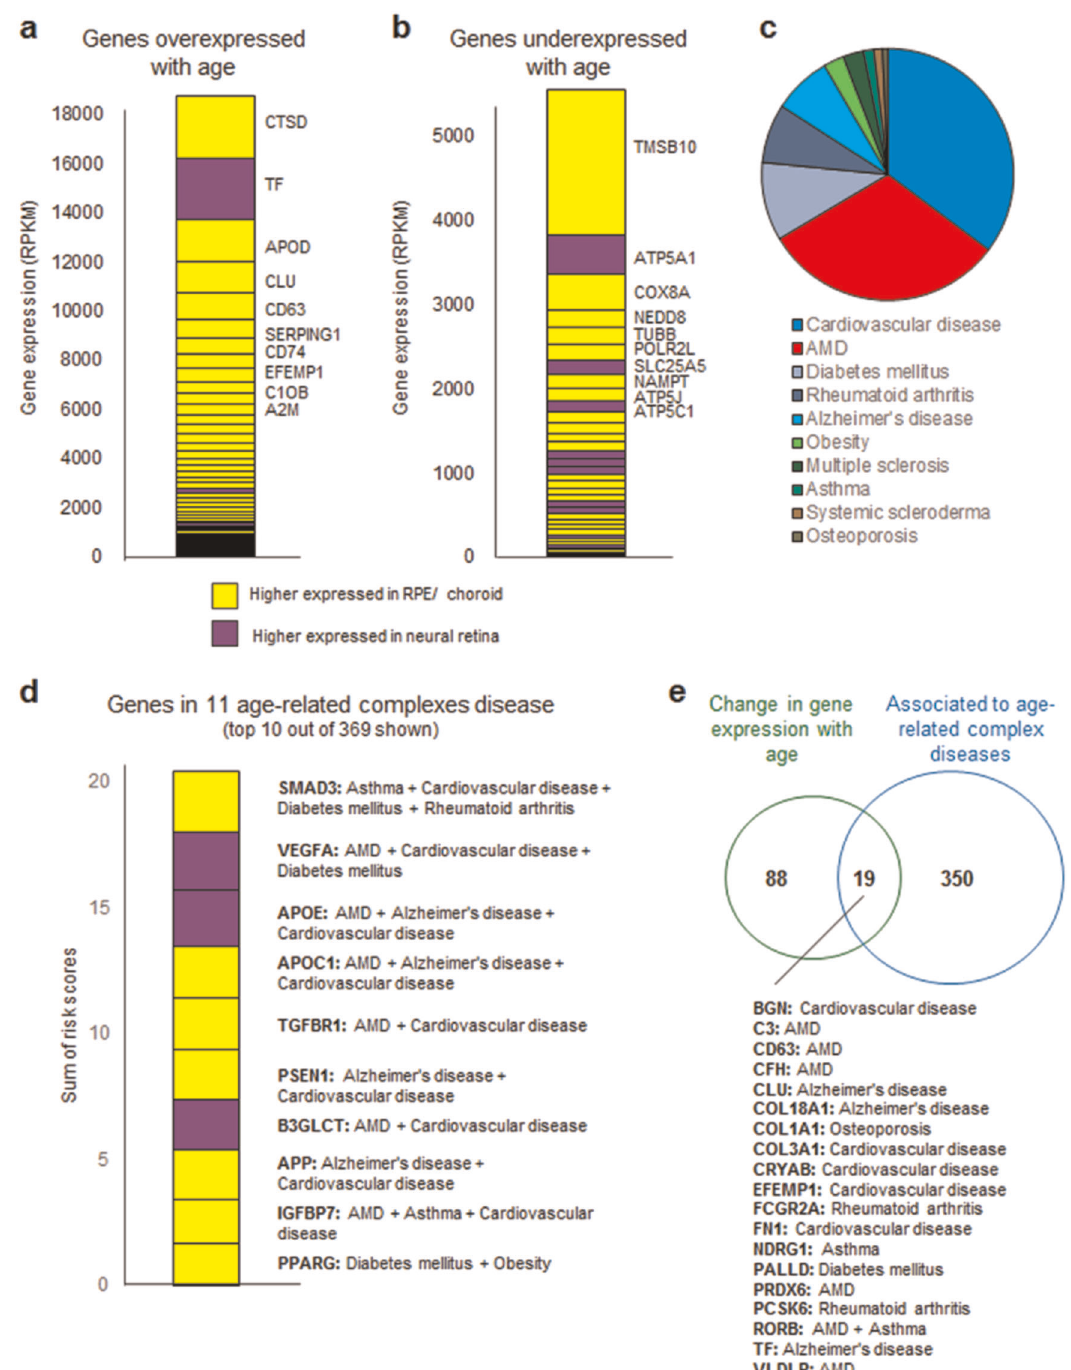
Fig. 5 Analyses of the 2060 SBGN-PPI union proteins. a Genes overexpressed with age and their respective expression levels in neural retina (purple) or RPE-choroid (yellow) are shown. a Genes underexpressed with age and their respective expression levels in neural retina (purple) or RPE-choroid (yellow) are shown. c Pie chart of sums of risk scores for all 2060 SBGN-PPI union genes in eleven age-related complex diseases. d Top ten genes with highest risk score in eleven age-related complex diseases. e Overlap of genes changing with age and associated to at least one age-related complex